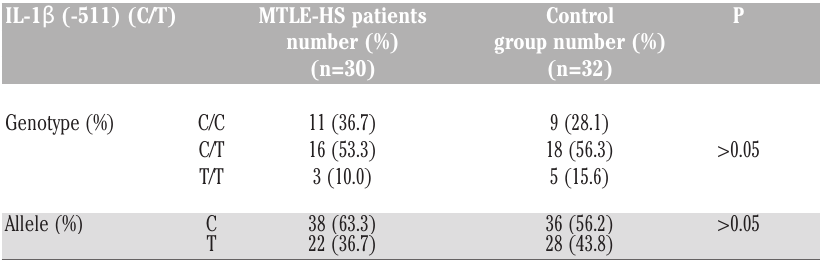
Table 2. Genotype and allele frequencies of interleukin